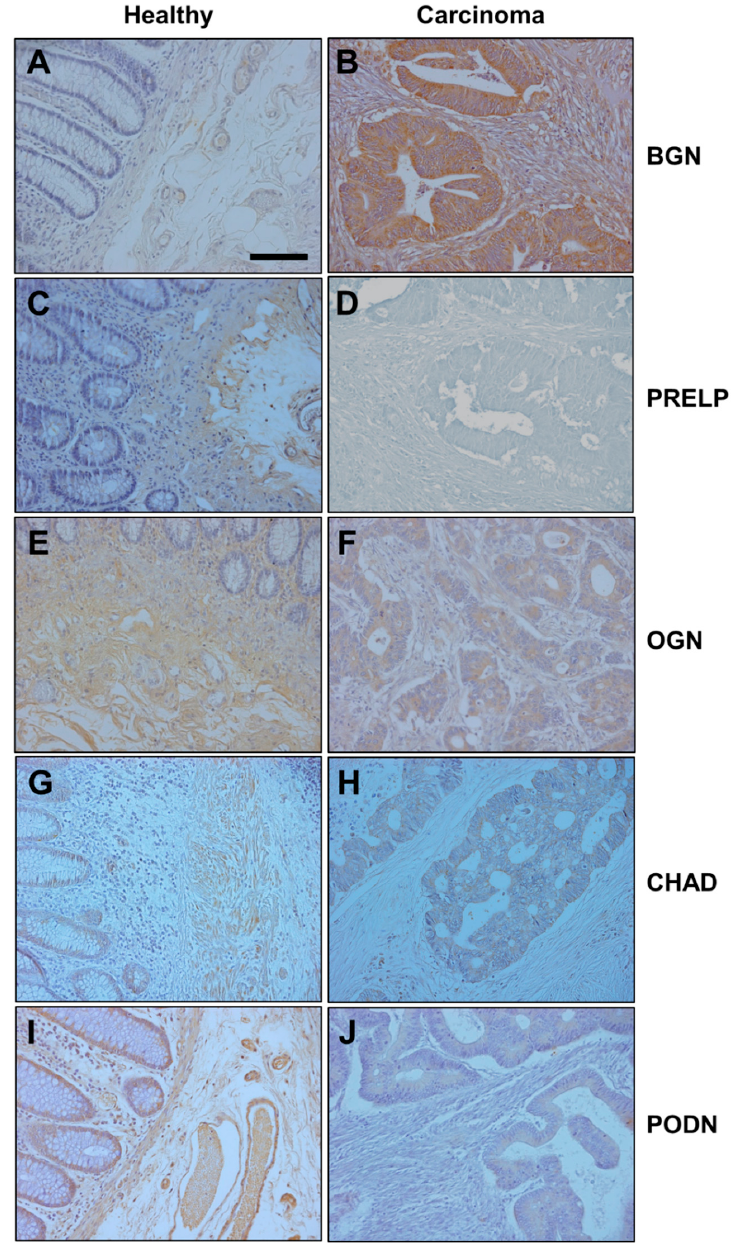
Figure 4. Immunolocalization of SLRPs with altered expression in LSCCs. ( A , B ) Histological localization of BGN expression: ( A ) Normal mucosa showing very weak staining; ( B ) Tumor tissue, showing intense expression in both the stroma and the cells. ( C , D ) Immunolocalization of PRELP expression: ( C ) Normal mucosa showing very weak staining; ( D ) Tumor tissue, showing intense expression in both the stroma and the cells. ( E , F ) Immunolocalization of OGN expression: ( E ) Healthy tissue showing moderate expression in the stroma; ( F ) Tumor tissue, in which a weak expression is observed in the tumor cells and very little in the stroma. ( G , H ) Immunolocalization of CHAD expression: ( G ) Normal mucosa showing weak expression in the absorptive cells and moderate expression in the stroma; ( H ) tumor sample showing weak and very focused expression in tumor cells. ( I , J ) Immunolocalization of PODN expression: ( I ) Control tissue in which moderate to intense expression is detected in the absorptive cells and a moderate staining in the stroma; ( J ) Neoplastic tissue showing weak staining in tumor cells. Magnification 200×, scale bar: 100 μ m.